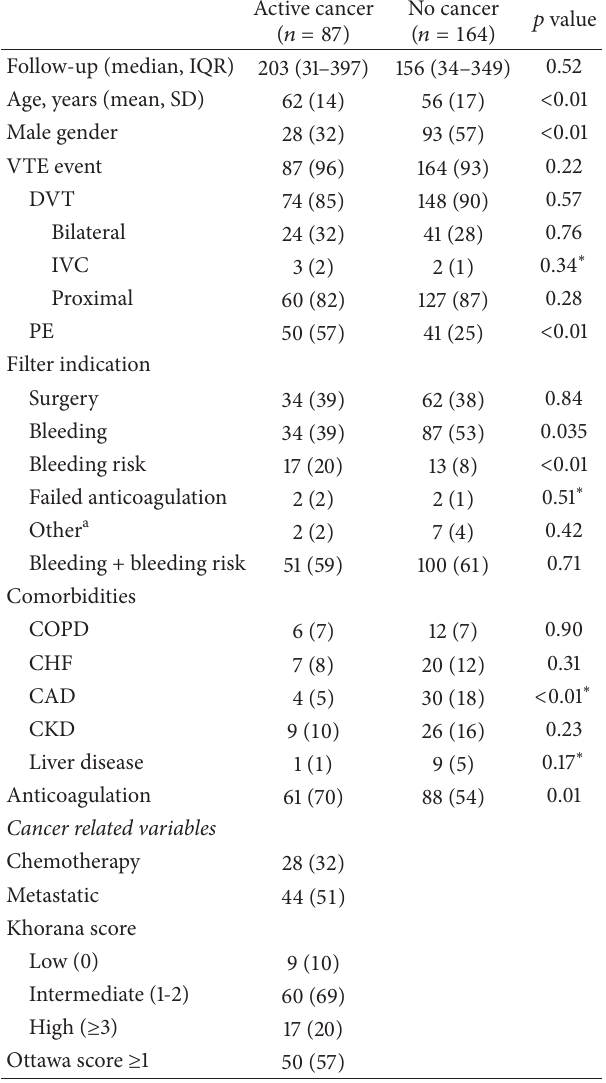
Table 1: Clinical characteristics of the subjects by cancer